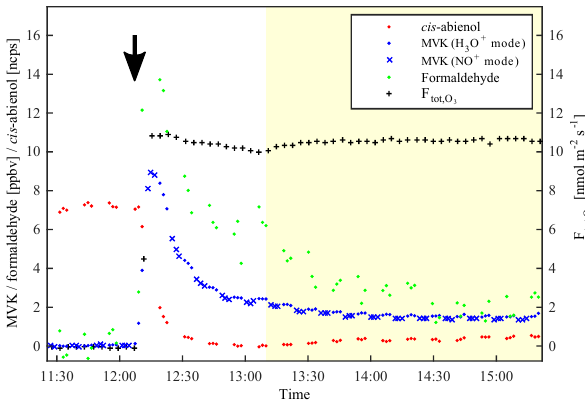
Figure 3. Temporal evolution of selected VOC in an ozonolysis ex- periment with an Ambalema plant and corresponding total ozone de- position flux F tot , O . The yellow shaded area denotes time ranges, 3 in which the sample plant was illuminated. Starting the fumigation with ∼ 60ppbv ozone (indicated by the black arrow) the cis -abienol signal decreased quickly. At the same time, the carbonyl products of cis -abienol ozonolysis, formaldehyde and MVK (measured in H 3 O + respectively NO + reagent ion mode of the SRI-ToF-MS), started to rise. The large scattering of the formaldehyde signal de- rives from the strongly reduced sensitivity of the SRI-ToF-MS un- der high humidity conditions towards this compound. Two hours after the start of the ozone fumigation an equilibrium between ac- tual diterpenoid production and loss due to surface reactions was established, resulting in stable signals of the oxygenated